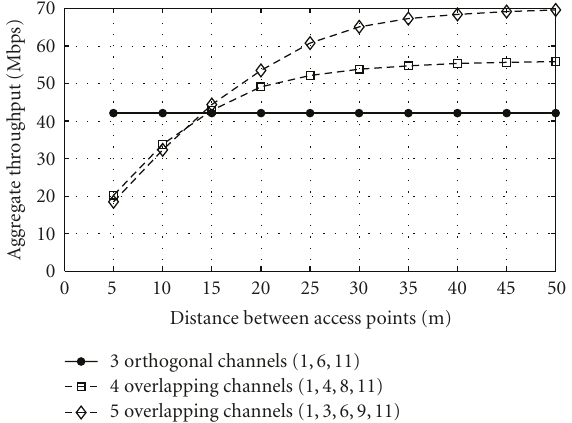
Figure 7: Performance in adjacent channel interference